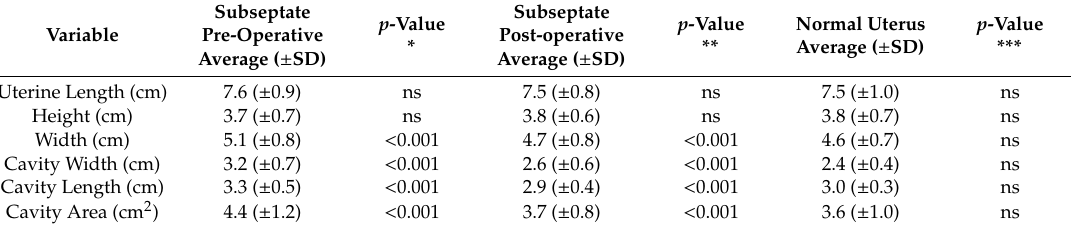
Table 1. Ultrasound uterine dimensions in women with uterine subseptations ≥ 3 mm (N = 126) before and after hysteroscopic incision, compared to the uterine dimensions in women with normal uteri (N = 89).